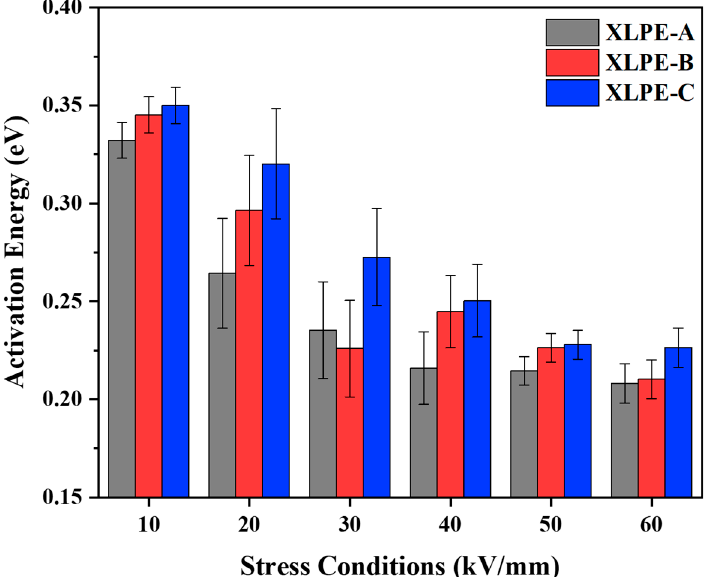
Figure 9. Activation energies (eV) under various stress conditions (kV/mm) of XLPE prepared with DCP content of 1.4% (XLPE-A), 1.7% (XLPE-B) and 2% DCP content of 1.4% (XLPE-A), 1.7% (XLPE-B) and 2% (XLPE-C).